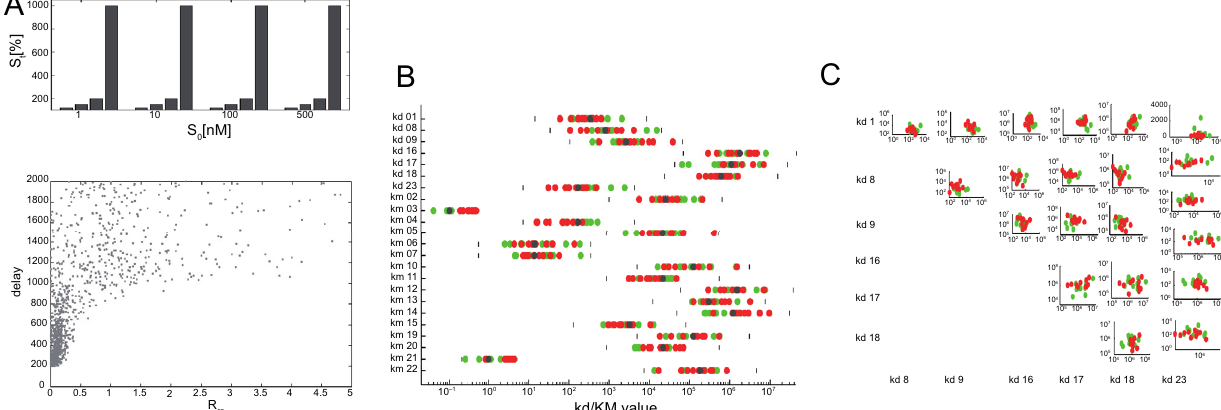
Figure 2. A . Distribution of systems according to R and d values. ~ 1600 different systems states were randomly generated with k-parameter variations (20–500%), R C,S and d values were measured with the signal set shown on top. B . Kd and KM parameters for high efficiency (red, f < 2) and low efficiency (green, f > 5) systems. C . Cross-correlation of Kd values.